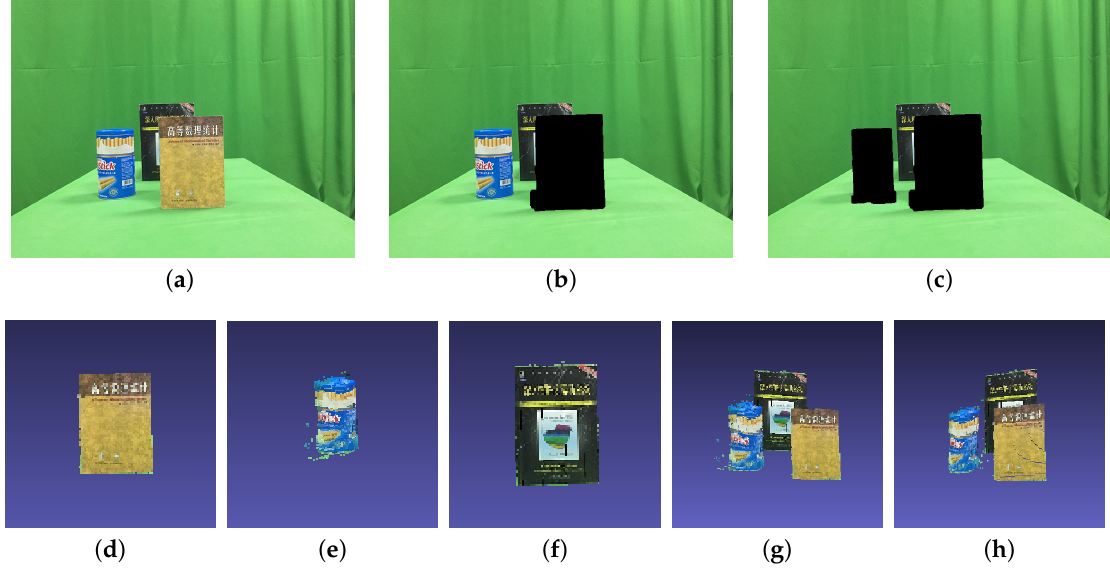
Figure A2. Reconstruction results of the can scene. ( a ) Reference camera view. ( b ) The front book removed. ( c ) Both the front book and the can removed. ( d ) Reconstructed front book. ( e ) Reconstructed can. ( f ) Reconstructed book behind. ( g , h ) Reconstructed scene in different